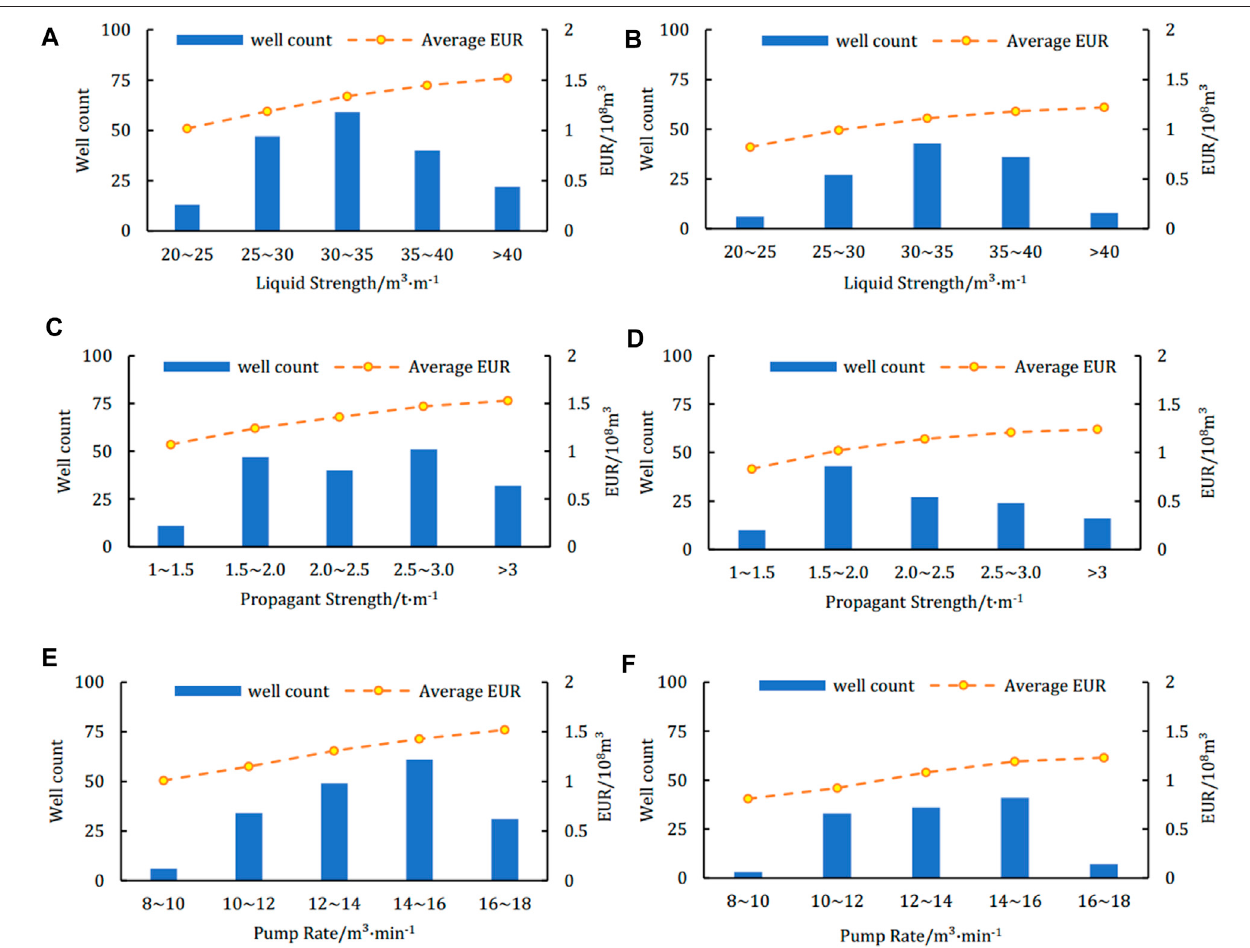
FIGURE 9 | Relationship between frac-parameters and EUR of gas wells in regions with M F greater and less than 0.5.